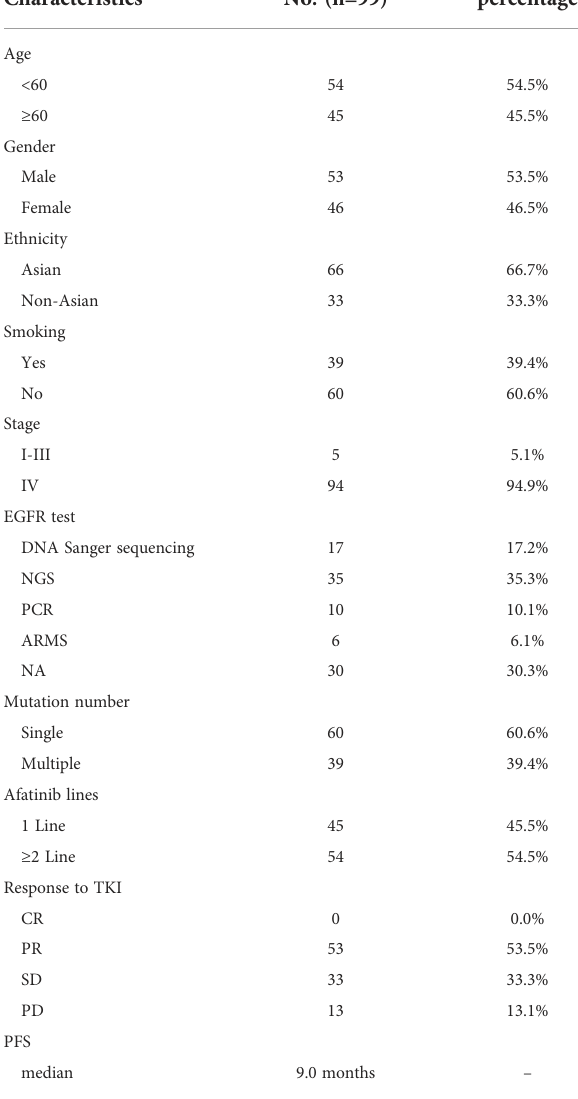
TABLE 1 Baseline characteristics.